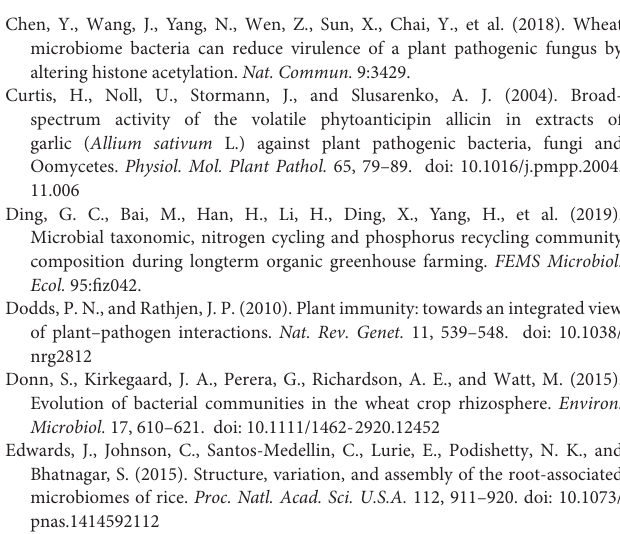
Supplementary Figure 1 | Schematic figure of the field sampling system and the experimental design. Treatments have organic and conventional two manipulation greenhouses. Initial healthy samples were collected when the experiment was conducted (4 weeks), and diseased samples were collected when the experiment was conducted (10 and 12 weeks after planting). Supplementary Figure 2 | Changes in the endophytic microbiome composition at the phylum level during the field experiment. The relative bacterial density dynamics in initial, healthy, and diseased tomato endophytic samples in the organic system greenhouse. Supplementary Figure 3 | Changes in the endophytic microbiome composition at the phylum level during the field experiment. The relative bacterial density dynamics in initial, healthy, and diseased tomato endophytic samples in the conventional system greenhouse. Supplementary Figure 4 | Evaluation of disease suppression effect by greenhouse bioassay ( N = 18). Supplementary Figure 5 | Percentage of different antagonistic bacteria in the Seedling and Fruiting